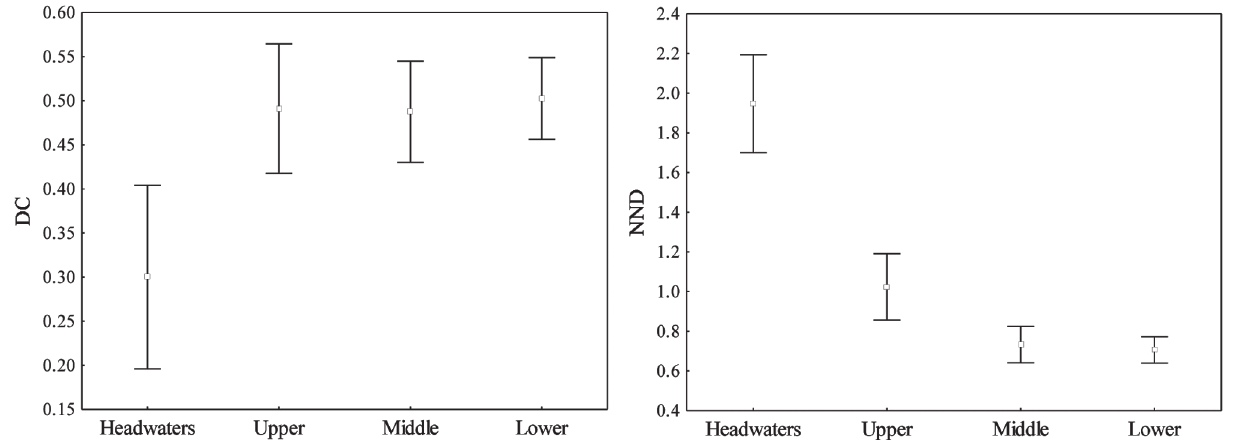
Fig. 3. Box plots of distance to the centroid (DC) and distance of each species to the nearest neighbor (NND) for headwaters, upper course, middle course and lower course of the rio das Velhas, with their respective means and standard